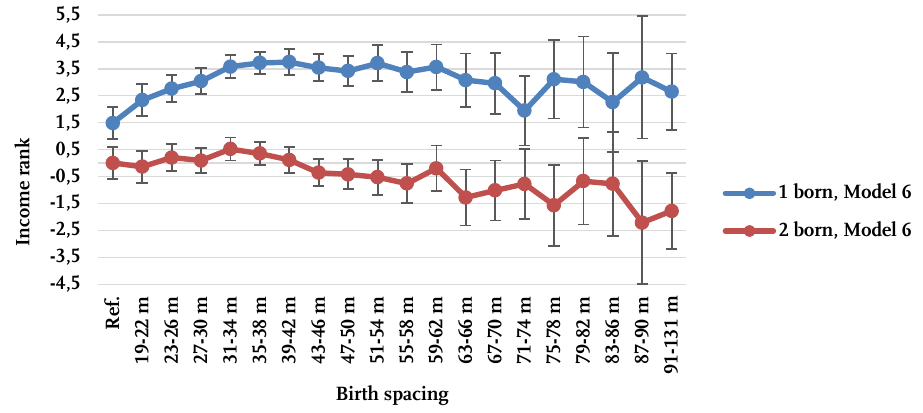
Figure 3 : First- and second-born siblings income rank across birth-spacing